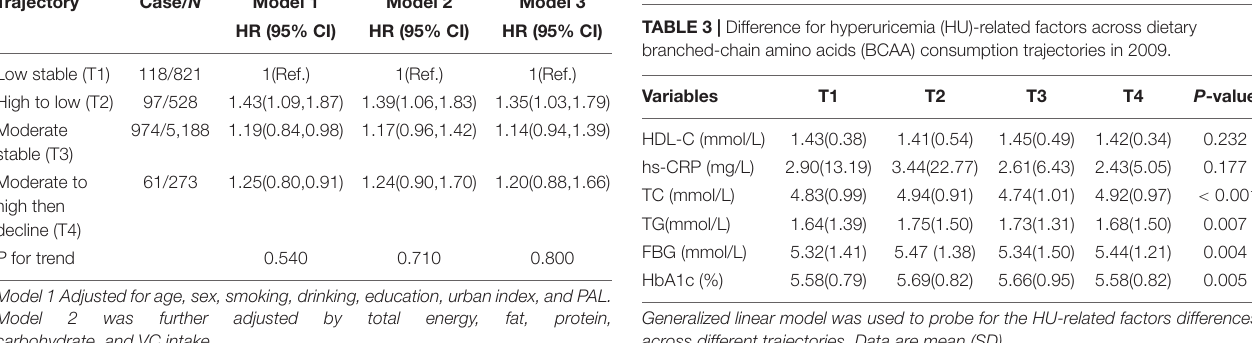
TABLE 2 | Association between dietary branched-chain amino acids (BCAA) consumption trajectories and hyperuricemia (HU) by Cox regression models. Trajectory